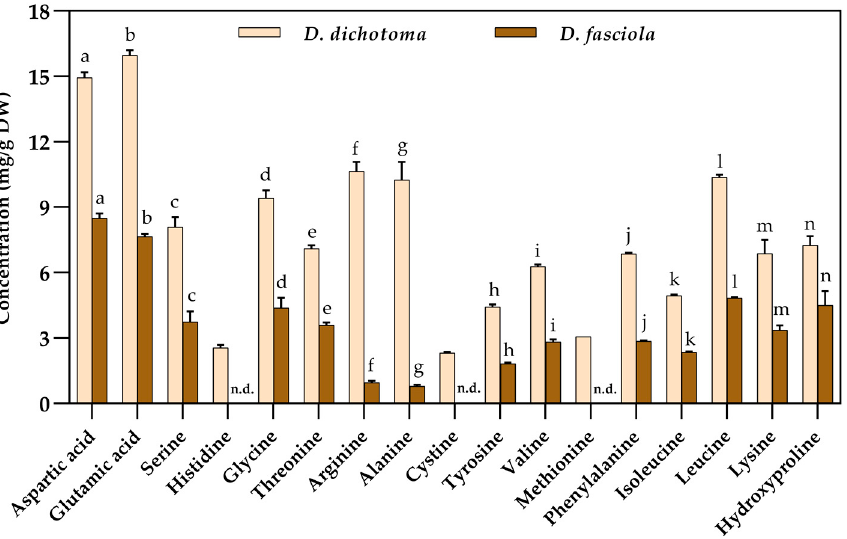
Figure 1. The amino acid composition of D. dichotoma and D. fasciola determined by UHPLC analysis. Common letters indicate a significant difference between the samples ( p < 0.0001). n.d. = not Common le tt ers indicate a signi fi cant di ff erence between the samples ( p < 0.0001). n.d. = not de- tected.